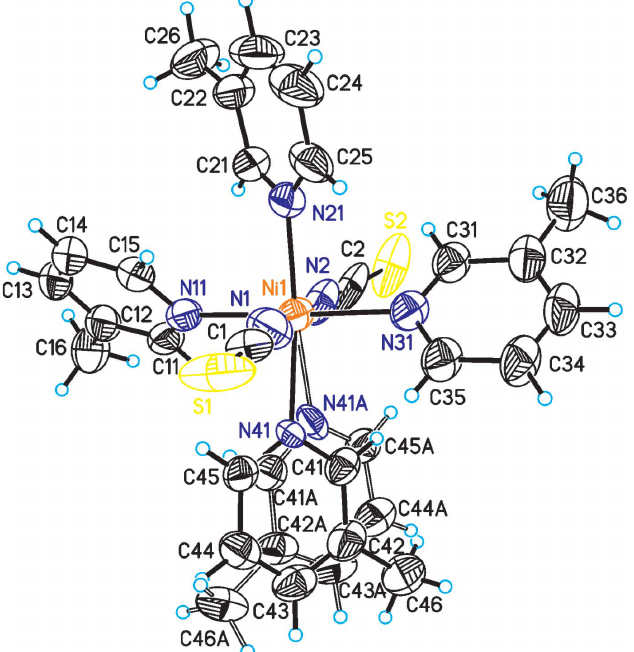
Figure 2 Crystal structure of the title compound with atom labeling and displacement ellipsoids drawn at the 50% probability level using XP in SHELX - PC (Sheldrick, 1996). The disorder of one of the 3-methyl- pyridine ligands is shown as full and open bonds.